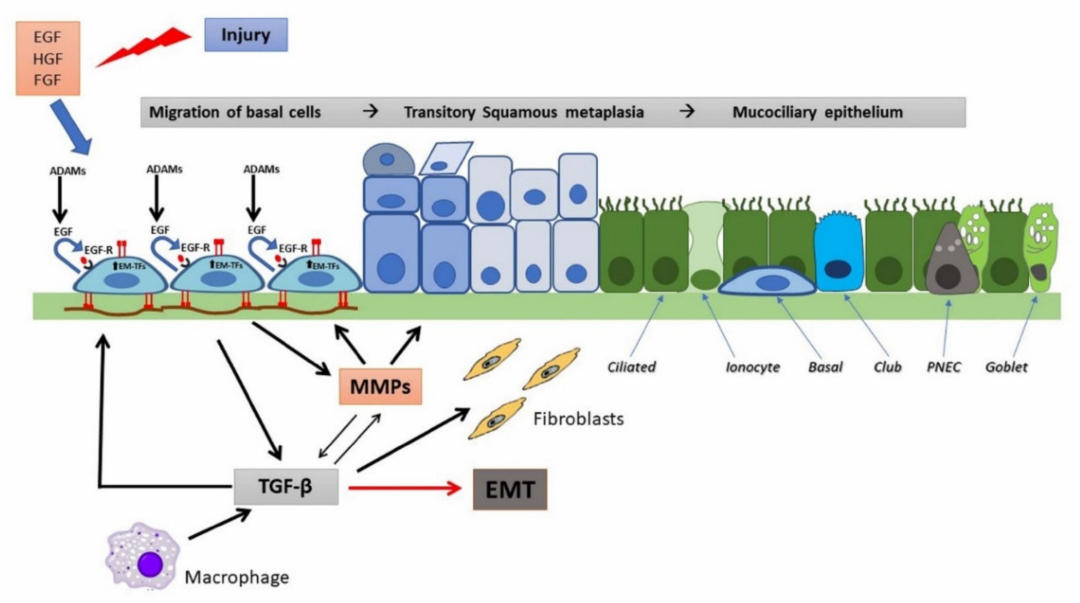
Figure 2. Wound repair and regeneration in a non-CF airway epithelium. Following injury, many cytokines and growth factors (e.g., EGF, HGF, FGF) are secreted in the wound repair microenvironment, which incite in basal cells a migratory and proliferative phenotype. Shedding of EGFR ligands (e.g., EGF) by ADAMs and binding to EGFR in an autocrine or iuxtacrine manner are key events involved in stimulation of cell migration and proliferation. Afterwards, MMP secretion by regenerating epithelial cells and subsequent TGF- β activation lead to genetic expression changes, related to EMT stimulation and activation of EMT-transcription factors (EMT-TFs). Epithelial cells and macrophages release TGF- β that induce ECM component deposition by epithelial cells and stimulate fibroblast activation, resulting in further matrix deposition. These events provoke alterations in junctional complexes and reorganization of actin cytoskeleton (not shown), modification of various integrin expression with β 1 -integrins increase at basal side and ectopic expression on the apical side, deposition of inflammatory ECM glycoproteins (e.g., fibronectin is shown) and its remodeling exerted by MMPs. TGF- β and MMPs enhance each other in a positive way. This process proceeds with the formation of a squamous stratified epithelium and subsequent pseudostratification and mucociliary